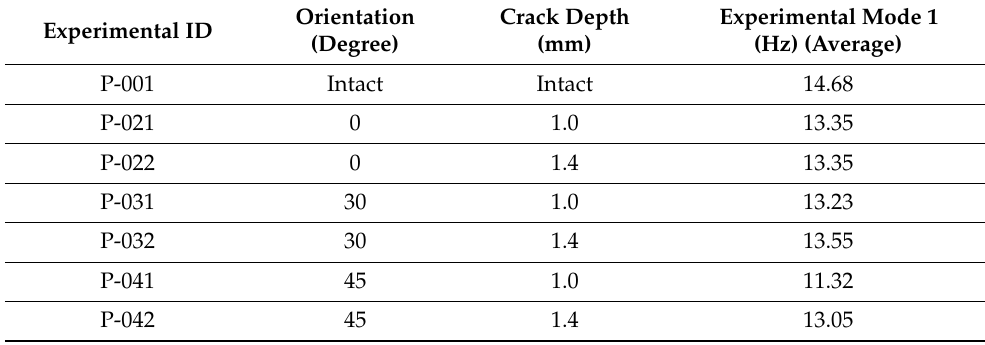
Figure 9. Crack depth ratio (CD/Original CD) vs. natural frequency for 0 ◦ , 30 ◦ , and 45 ◦ crack orientation. Table 4. Summary of the first natural frequency of samples with different damage scenarios.